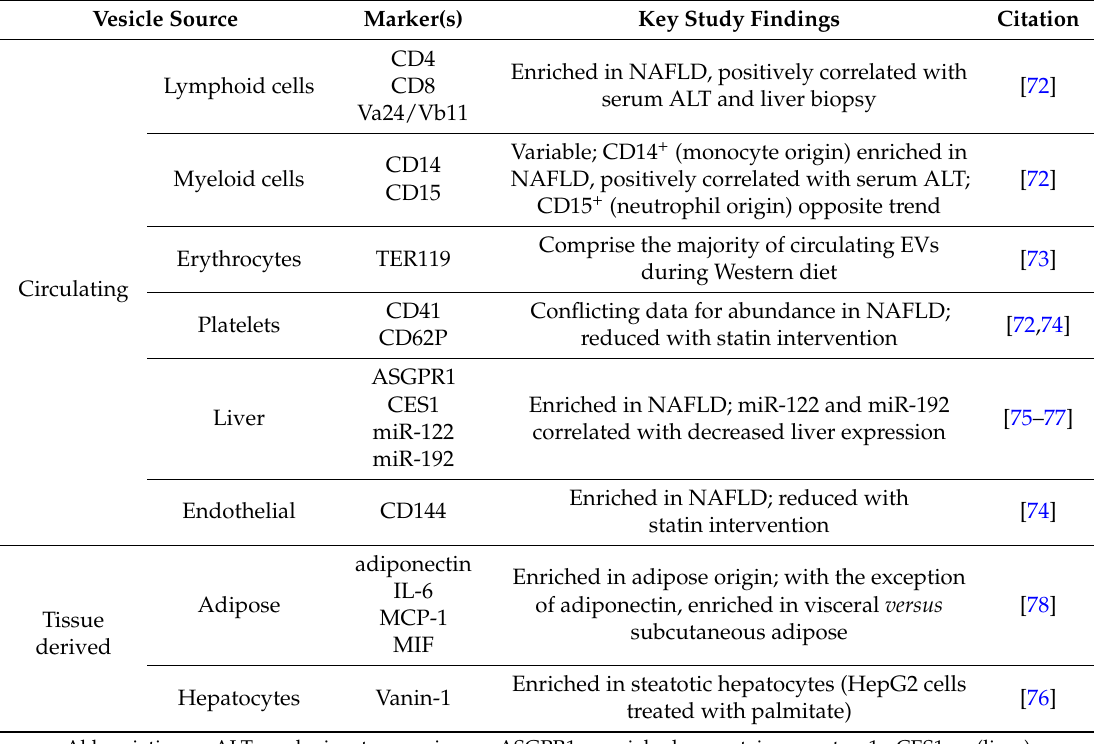
Table 1. Extracellular vesicle markers in non-alcoholic fatty liver disease (NAFLD) studies. Vesicle Source